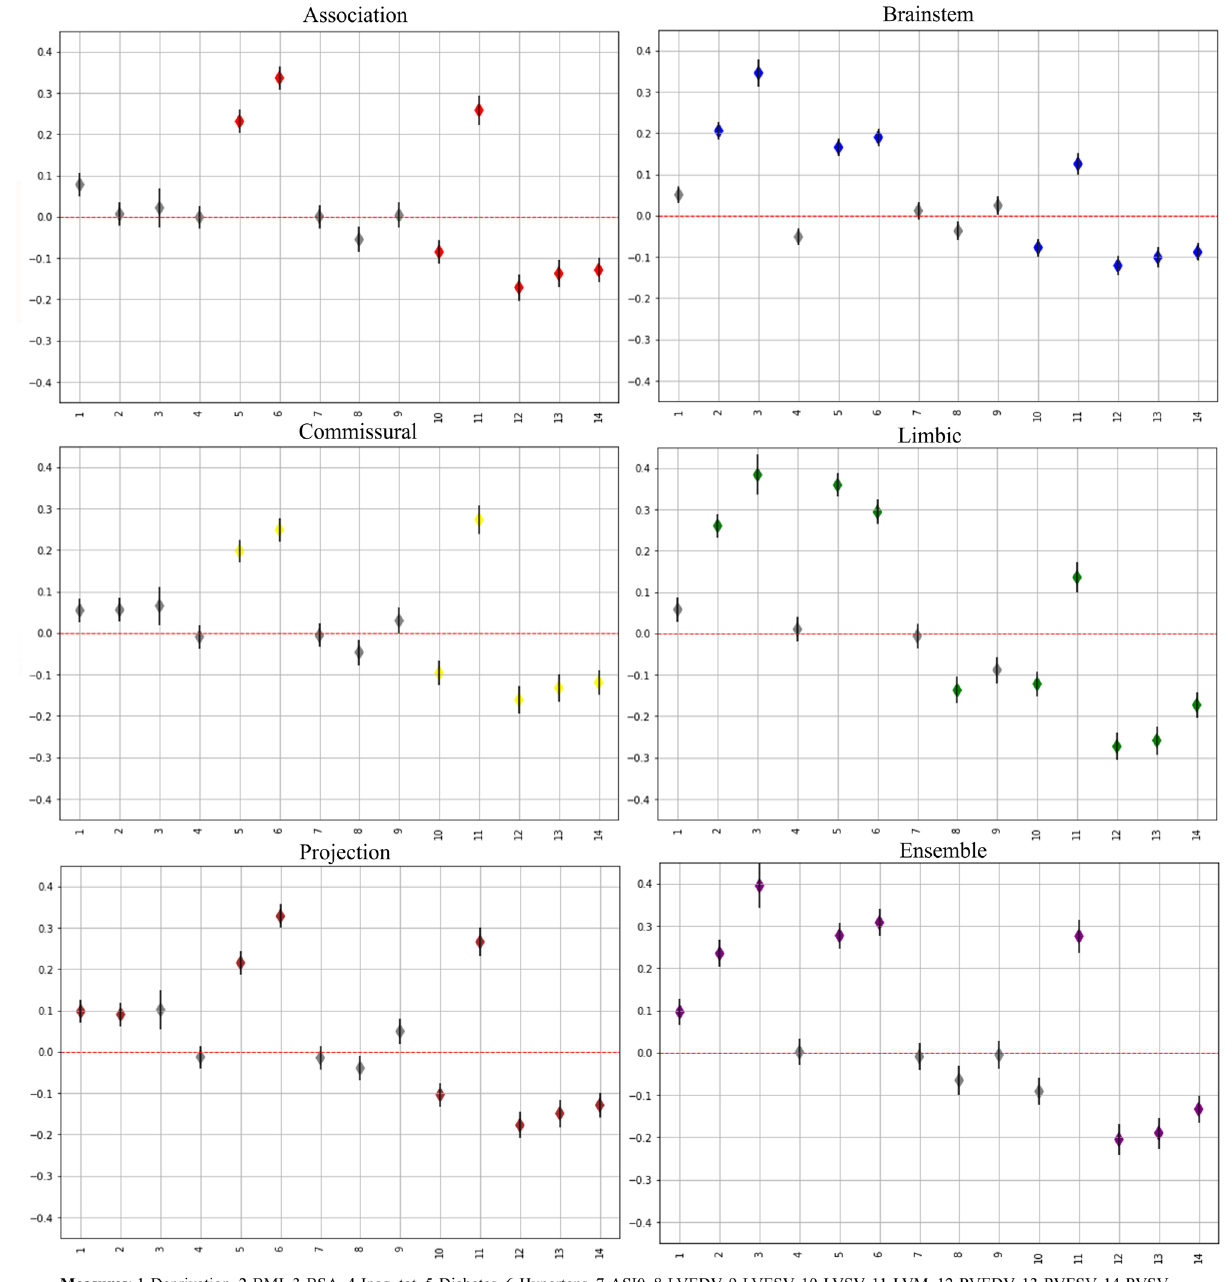
Figure 3. Association of the CMR measures, CRFs and brain-PAD. For each model, the numbers on the x-axis represents the order of the different CMR and CRFs measures summarised in the legend, while the regression coefficient (the diamond shape represents the beta coefficient) values are reported in the y-axis along with their standard error. Grey color indicates non-significant